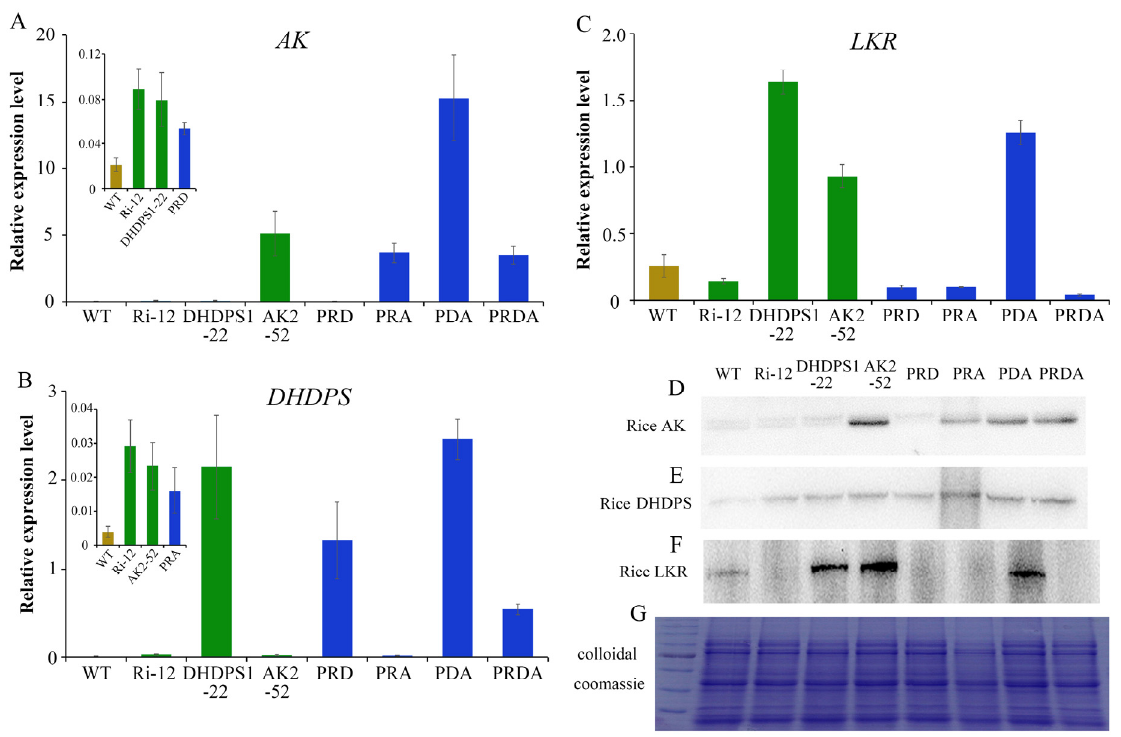
Figure 2. Expression analysis of AK, DHDPS, and LKR genes in developed rice seeds from the transgenic and wild-type (WT) rice. ( A – C ) Transcription level analysis of AK, DHDPS, and LKR genes in developed seeds obtained 15 days after flowering (DAF). ( D – F ) Western blot analysis of AK, DHDPS, and LKR proteins in developed seeds obtained 15 DAF. ( G ) SDS-PAGE analysis of total protein contents.